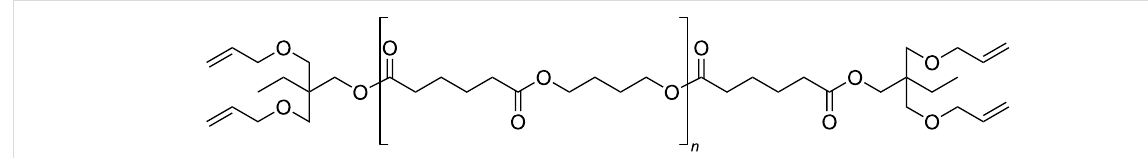
Figure 22: Telechelics with allyl-ether ends.